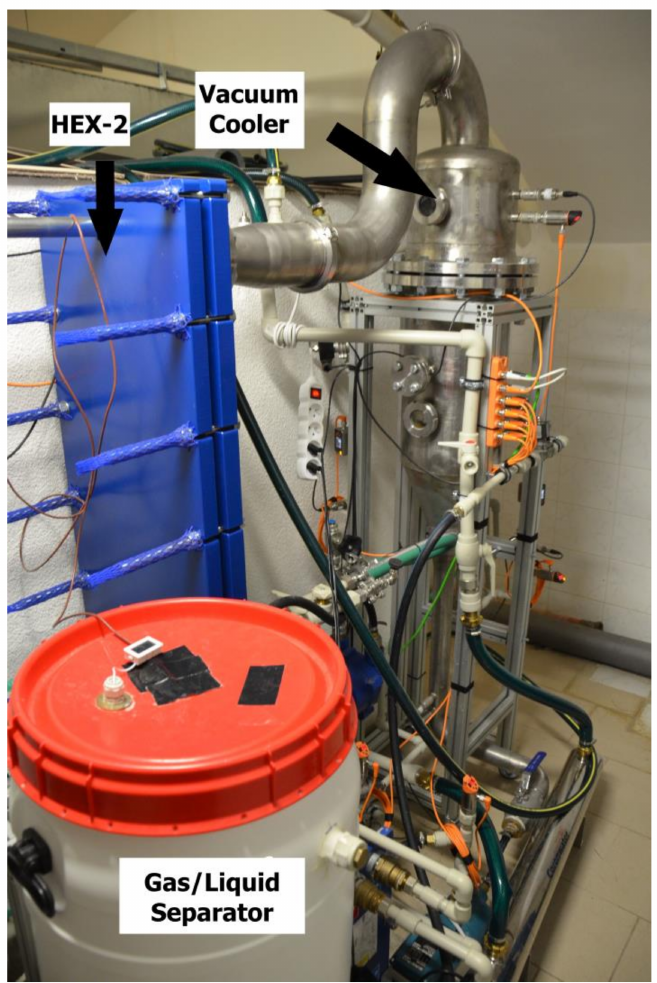
Figure 5. Pilot unit in live operation at the balneological